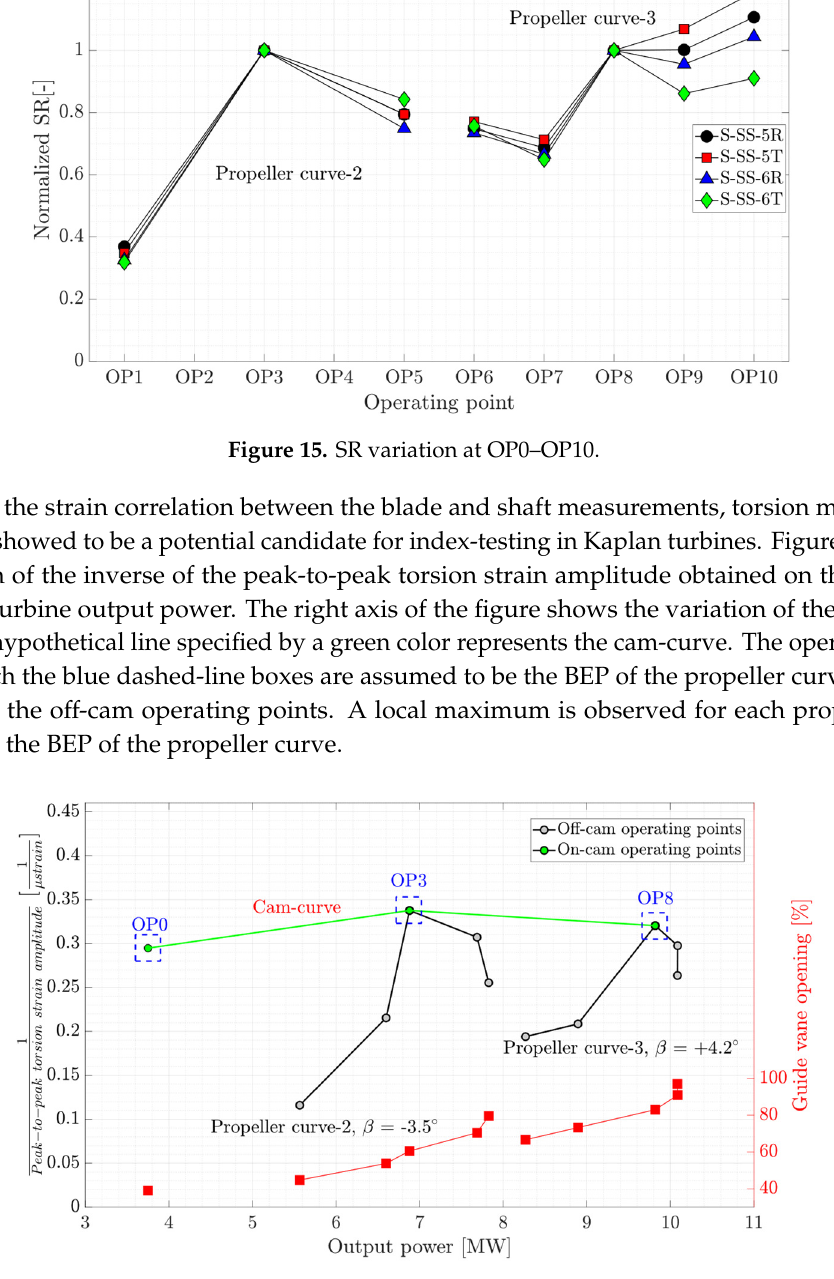
Figure 16. Inverse of peak-to-peak torsion strain amplitude obtained on the shaft as a function of turbine output power. The red lines correspond to guide vane opening. The green line is a hypothetical cam-curve and blue dashed-line boxes indicate the on-cam operating points.